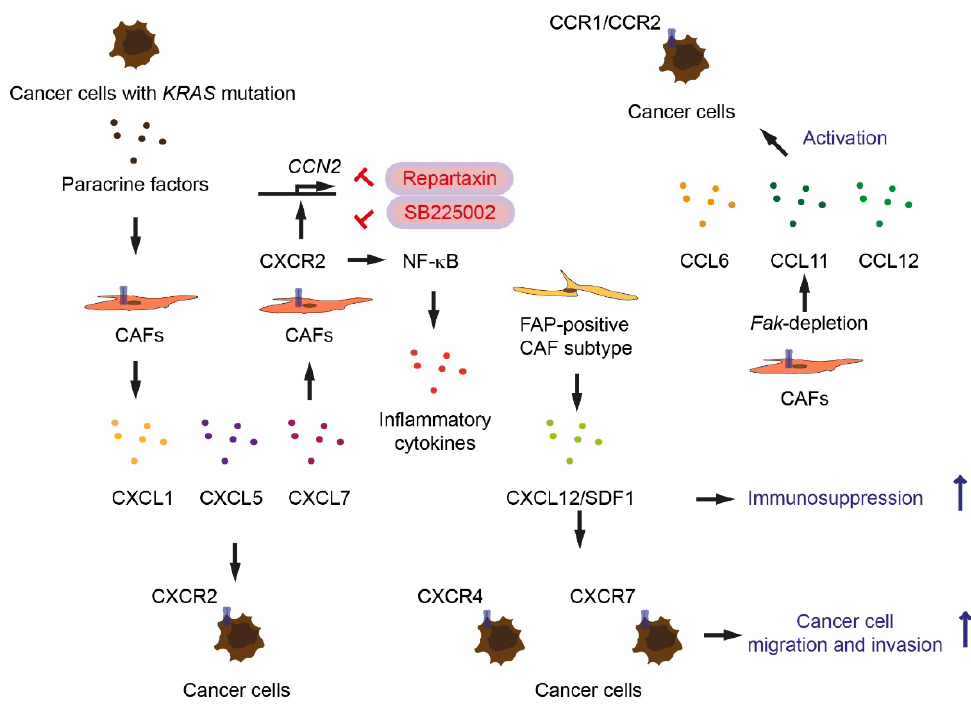
Figure 3. Chemokines and chemokine receptors as paracrine and paracrine-reciprocal factors for cancer-associated fibroblasts (CAFs) and tumor cells. Arrows indicate activation or induction. Inhibition symbols are colored in red.